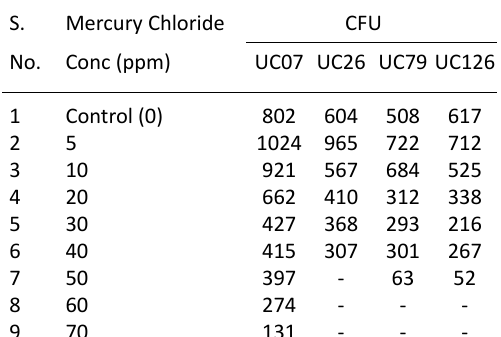
table 3. Acclimatization of Ulhas clones at different